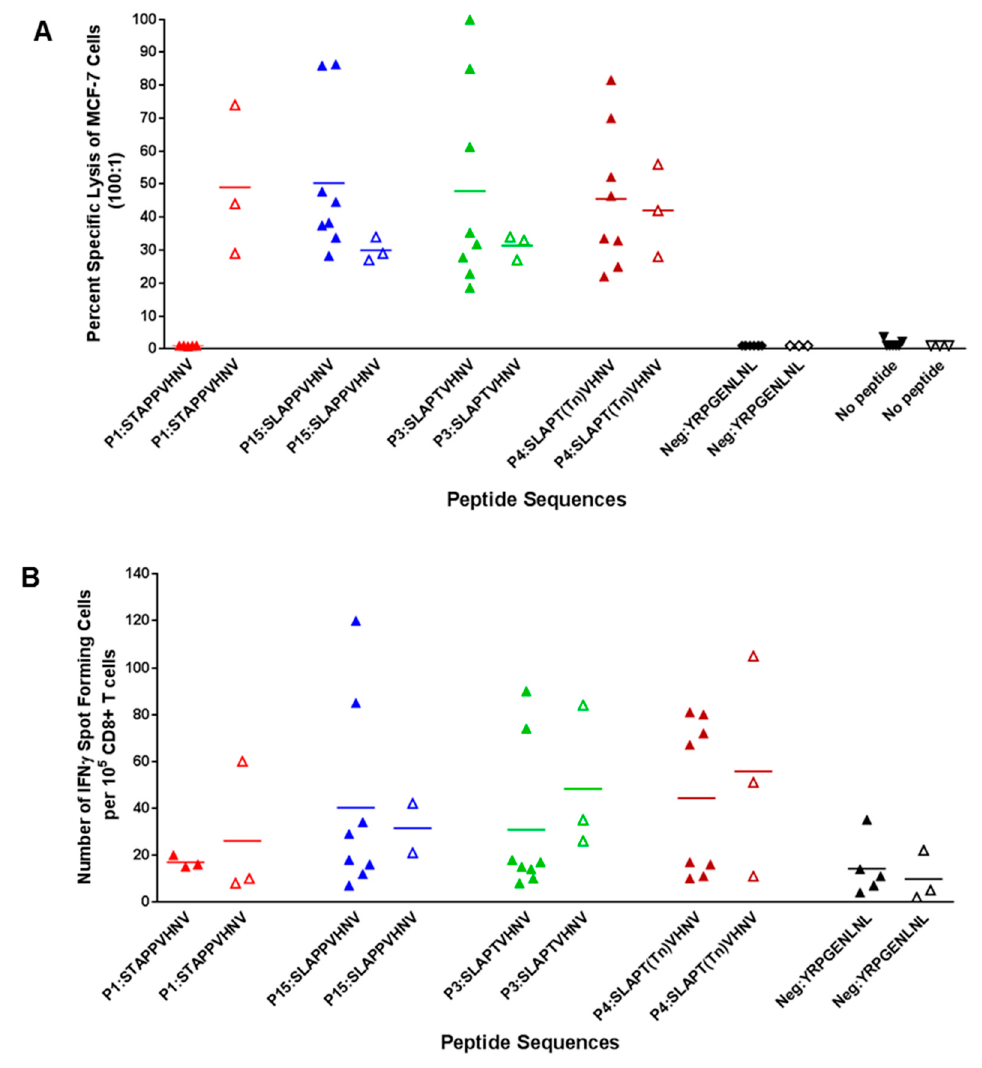
Figure 7. In vitro stimulation of T cells from HLA-A*0201 + cancer patients (peri-menopausal) with anchor-optimized and/or glycosylated MUC1 peptides elicited strong CTL activity. ( A ) PBLs underwent two rounds of stimulation and sorted CD8 + T cells were subjected to a 51 Cr-release assay. Targets were MCF-7 cells (HLA-A*0201 + , MUC1 + ). Effector:target ratio was 100:1 and spontaneous release was less than 25% of complete lysis. The filled triangles designate normal individuals and the open triangles designate breast cancer patients. For the peptides P3 and P4, there was no evidence that % specific lysis of MCF-7 cells in response to the peptide differed between the healthy donors and those with cancer (rank sum test; p > 0.05), although for the P1 peptide, there was evidence that the response to the peptide was greater in healthy donors than in those with cancer (Wilcoxon rank sum test; p = 0.04); ( B ) Production of IFN γ by CD8 + T cells was induced in response to MUC1 peptides. Following two rounds of stimulation, CD8 + cells were maintained for 24 h on an ELISpot plate. Spot numbers were determined using computer assisted video image analysis by Zellnet Consulting Inc. (FortLee, NJ, USA). There was no evidence of a significance difference in spot numbers between cancer patients and healthy controls (Wilcoxon rank sum test; p >